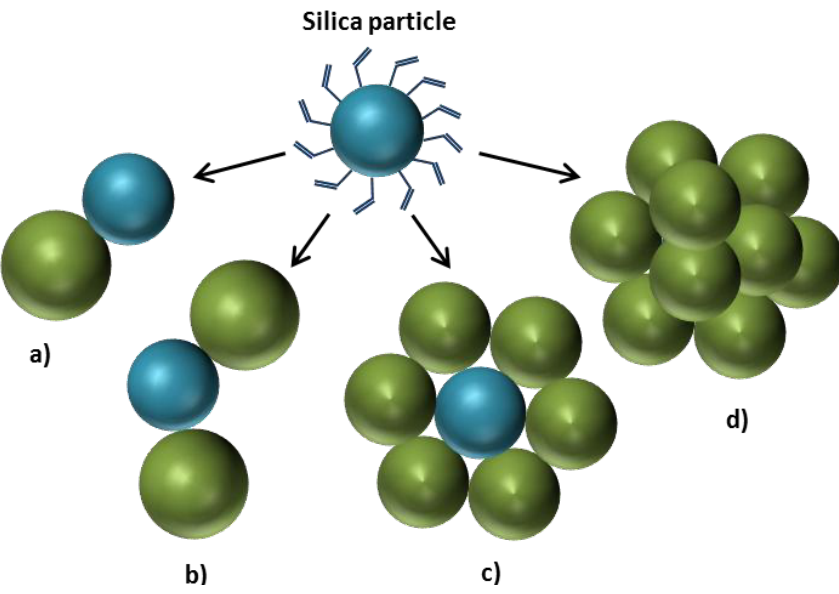
Figure 8. Morphology control over polystyrene growth on silica nanoparticles: ( a ) polystyrene/silica ratio equal to 1; ( b ) polystyrene/silica ratio equal to 2; ( c ) polystyrene/silica ratio equal to 6; ( d ) polystyrene in excess respect to silica. (Self-drawn scheme based on the strategy reported in